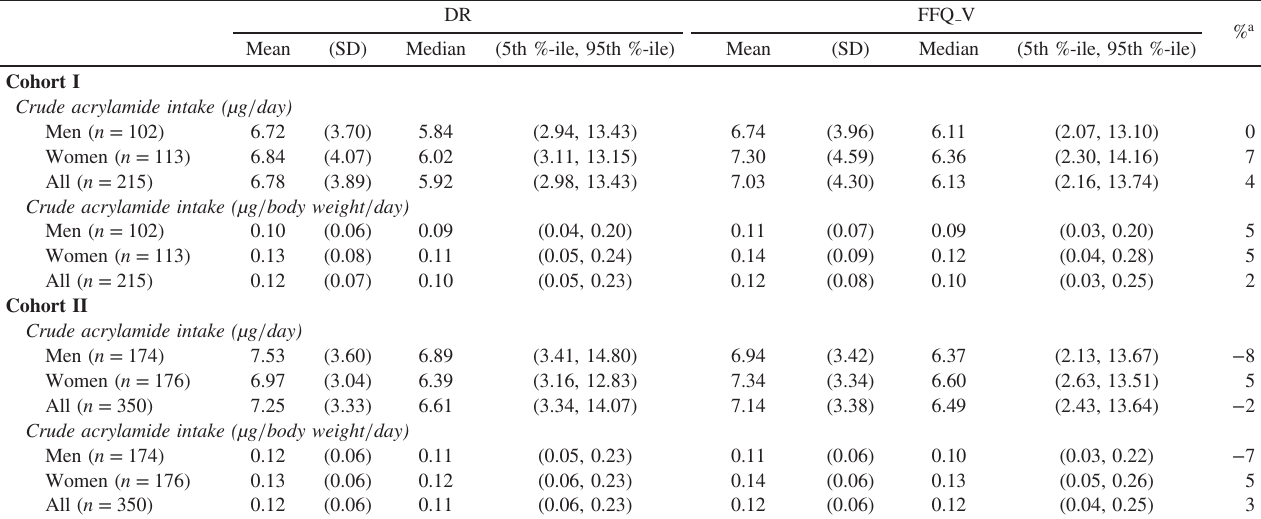
Table 1. Comparison of mean acrylamide intake from DR and FFQ